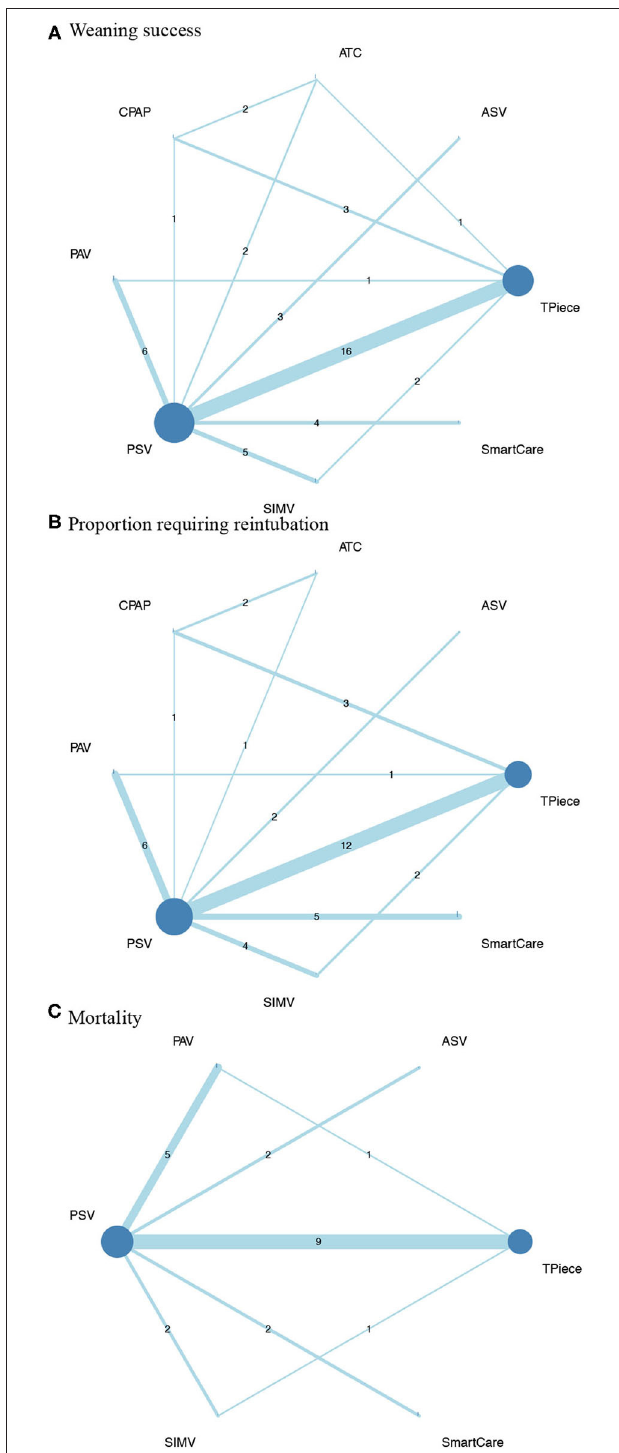
FIGURE 2 | Network plot of comparisons in (A) , weaning success (B) , proportion requiring reintubation, and mortality among different ventilator modes (C) . ASV, Adaptive support ventilation; ATC, Automatic tube compensation; CPAP, Continuous positive airway pressure; PAV, Proportional assist ventilation; PSV, Pressure support ventilation; SIMV, Synchronized intermittent mandatory